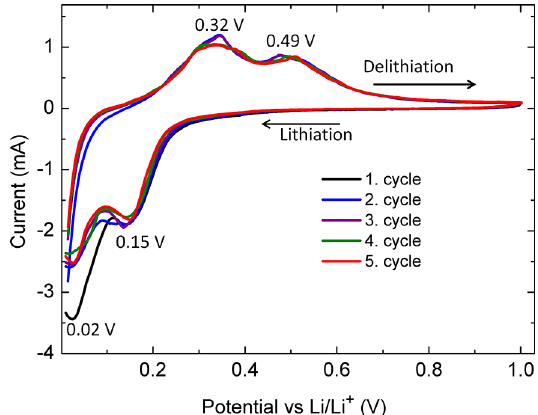
Figure 3. Cyclic voltammogram (CV) versus Li/Li+ profiles of n type highly doped nanowire electrode (sample #3) at a scan rate of 0.1 mV/s over the potential window of 0.01 V to 1.00 V for the first 5 cycles.